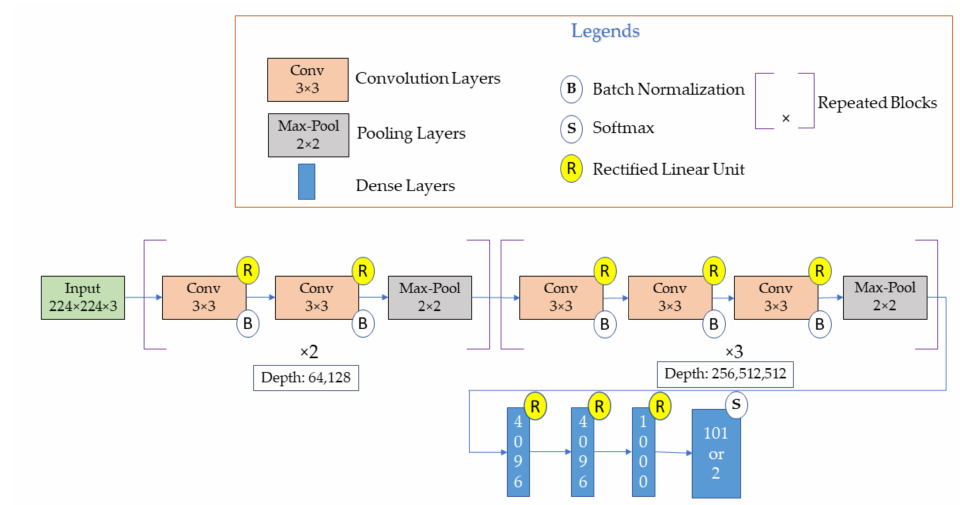
Figure 6. The deployed CNN architecture for the age and gender